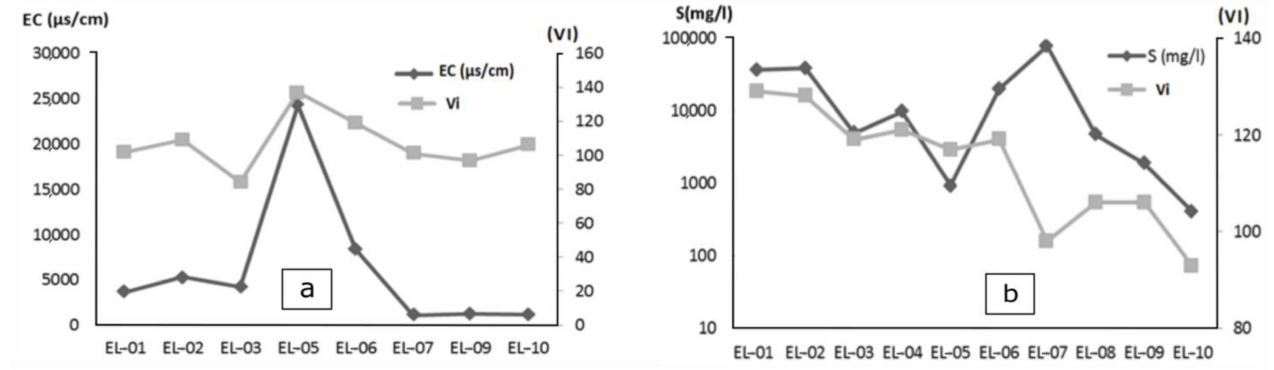
Figure 15. Relation between groundwater electric conductivity (EC) ( a ), groundwater sulfur (S) concentration ( b ), and the vulnerability index values from the Ouixane